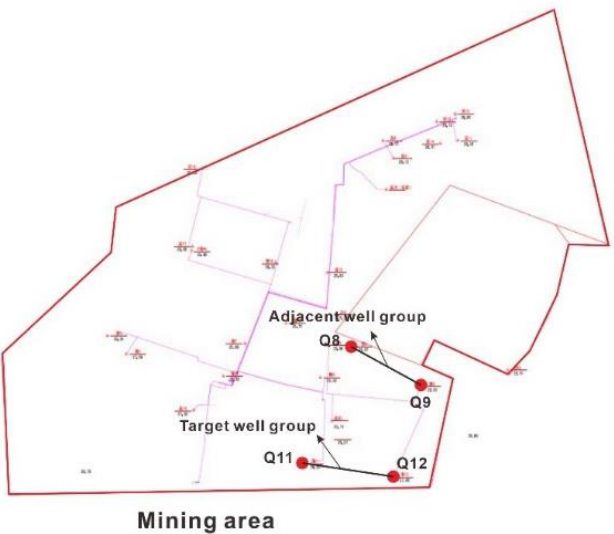
Figure 9. Well Distribution Map of Mining Area in ZY Salt Chemical Company.